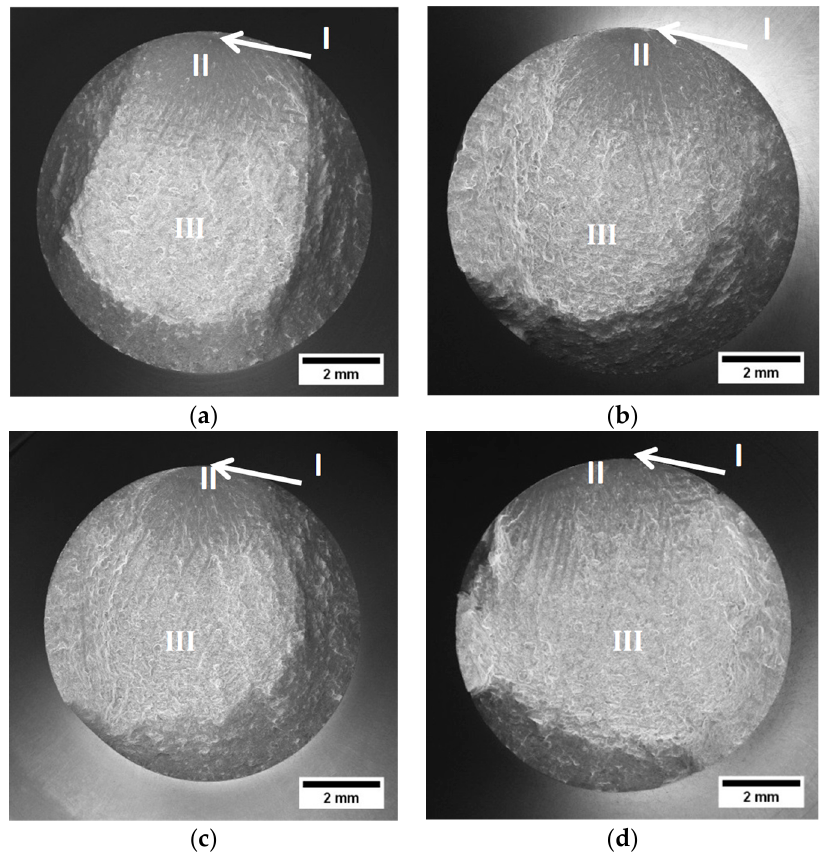
Figure 11. Views of fatigue fracture surfaces of MP samples loaded at a maximum stress of ( a ) 185 MPa, ( b ) 205 MPa, ( c ) 225 MPa, and ( d ) 245 MPa. ( b ) 205 MPa, ( c ) 225 MPa, and ( d ) 245